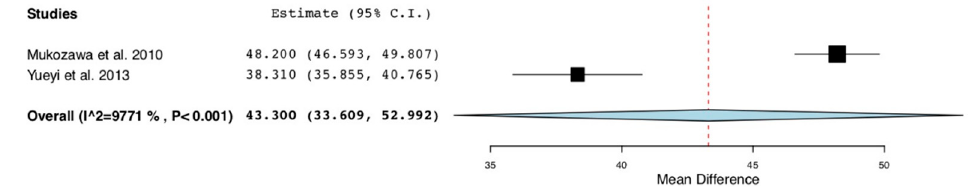
Figure 5. Forest plot: studies evaluating the percentage of bone formation at 12 weeks after the local application of statins in the treatment group versus no introduction of filling material or the introduction of polylactic acid in the control group.